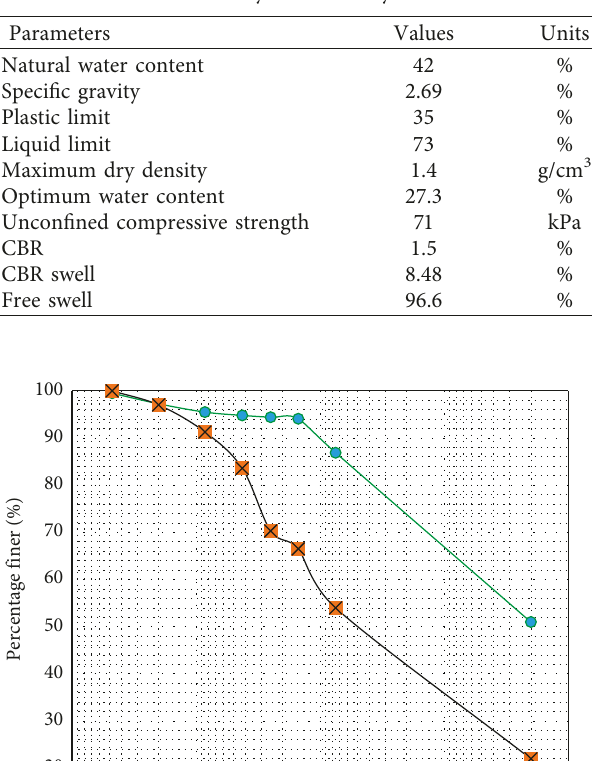
Table 1: Summary of laboratory test results.